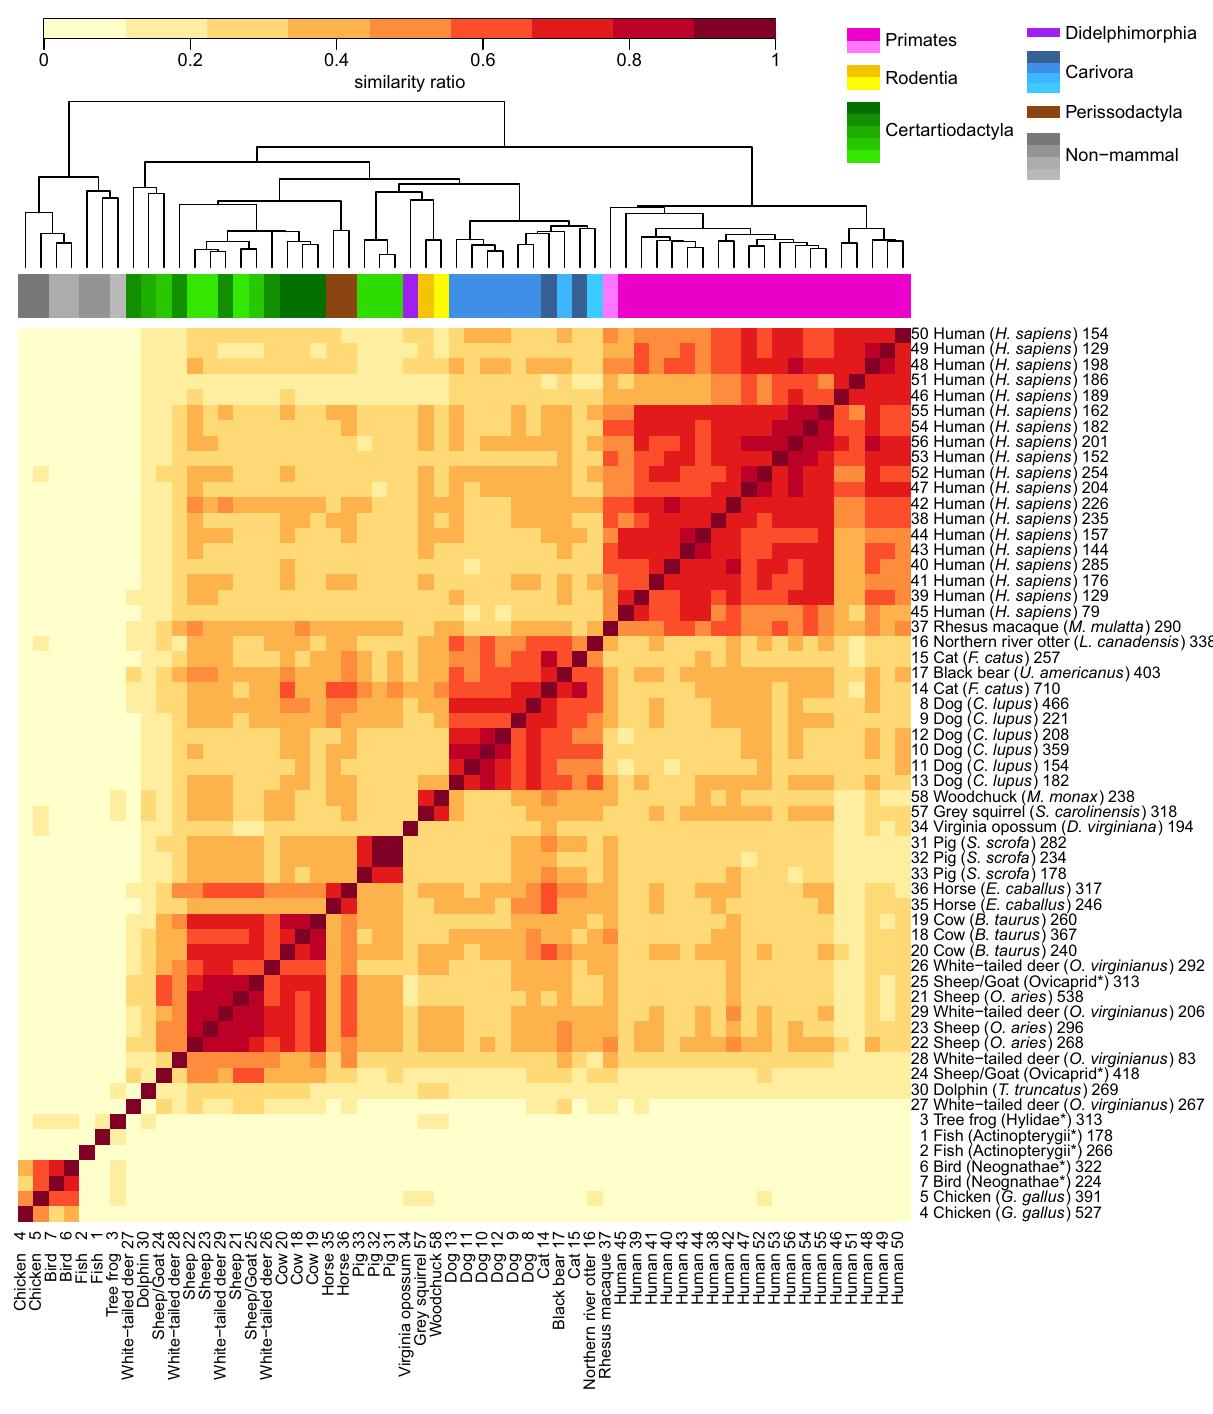
Figure 4. Heatmap and hierarchical clustering of pairwise comparison of bone sample spectra. Symmetric heat map of similarity ratios between all bones. Darker red indicates greater similarities between samples, light yellow indicates samples with a few or no spectra in common. Importantly, sample clustering coincides, for the most part, with evolutionarily similar taxa as seen in the dendrogram and taxa color-coded bar at top of figure. On the right axis the total number of spectra for each sample is listed along with common and Latin names of species, or most specific known taxa, indicated by * (see “Methods” for